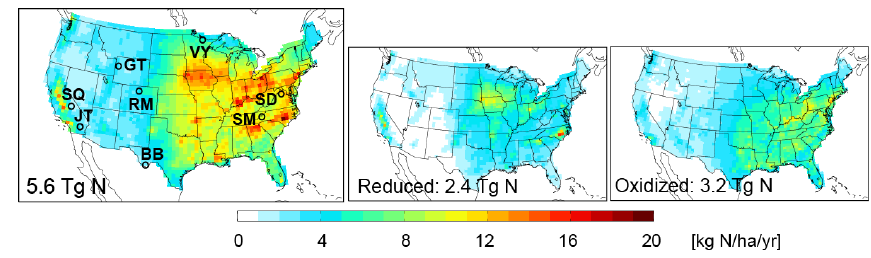
Figure 2. GEOS-Chem modeled Nr deposition in 2010. Select Class I areas for case studies are indicated by initials. Inset number is the annual contiguous US total Nr deposition.